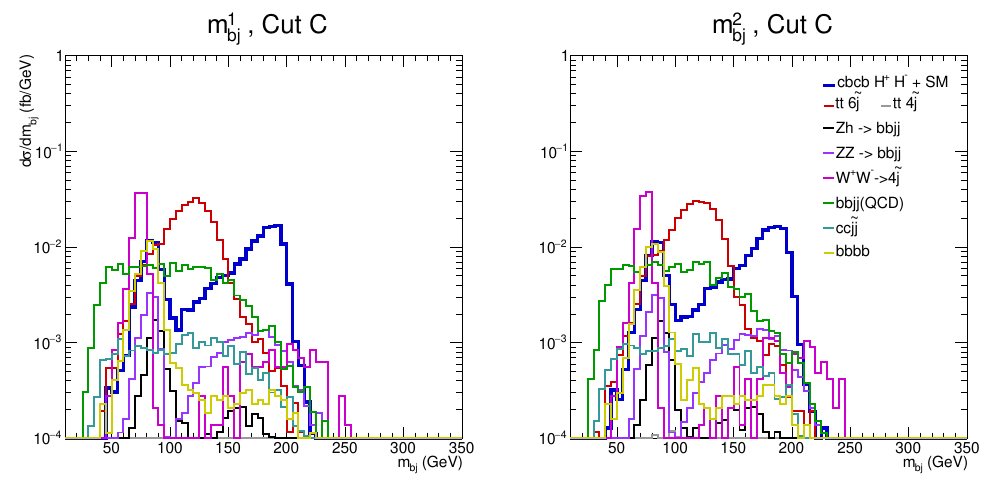
Figure 3 . Reconstructed m bj from both bj pairs, following Cut C, eq. (4.1). See text for more de-